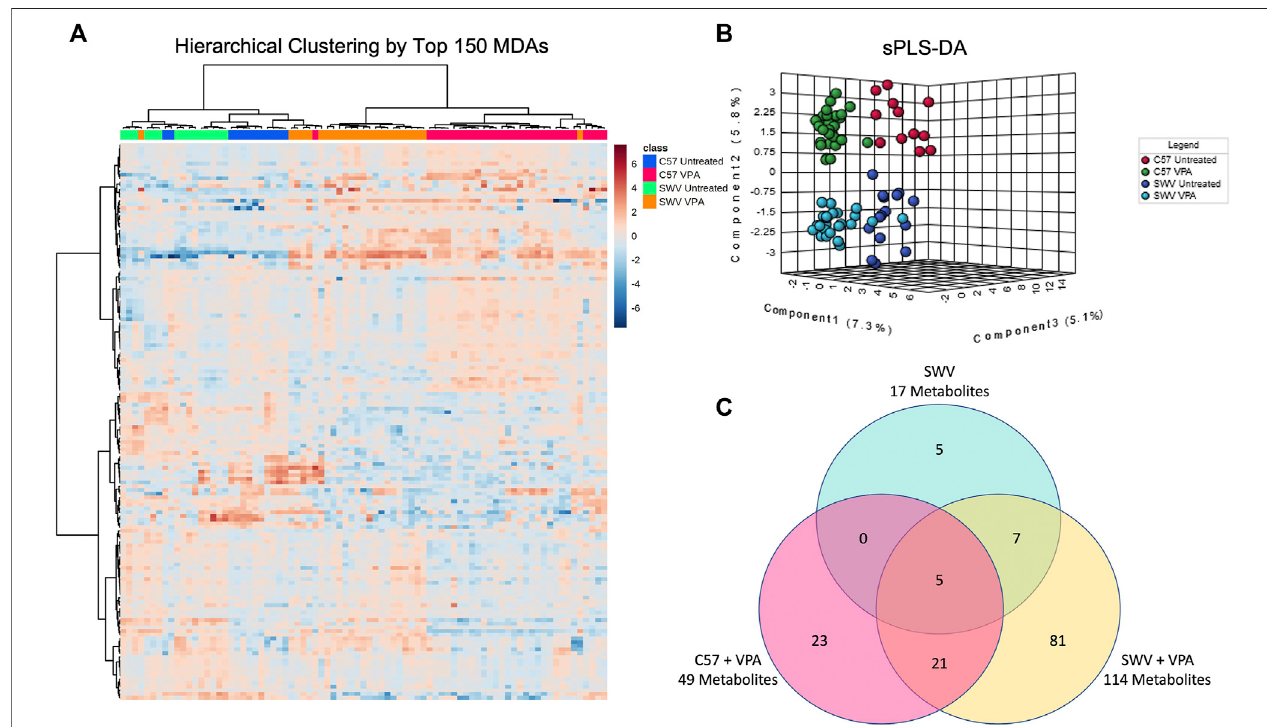
FIGURE 2 | Strain-dependent metabolic signatures associated with VPA exposure. (A) Untargeted hierarchical clustering based on 150 highest ranked metabolites of differential abundance (MDAs) after FDR correction. Metabolites are clustered in rows, while columns represent individual embryos. Each column is marked with a colored bar signifying the classi fi cation of the corresponding embryos by strain and VPA treatment group. The row and column dendrograms represent clustering by Pearson correlation using Ward ’ s linkage method. (B) Metaboanalyst sparse partial least squares discriminant analysis (sPLS-DA) demonstrating distinctive clustering of embryos by treatment and strain. (C) Venn-diagram displaying number of MDAs in SWV, C57 VPA, and SWV VPA embryos compared to untreated C57 controls.